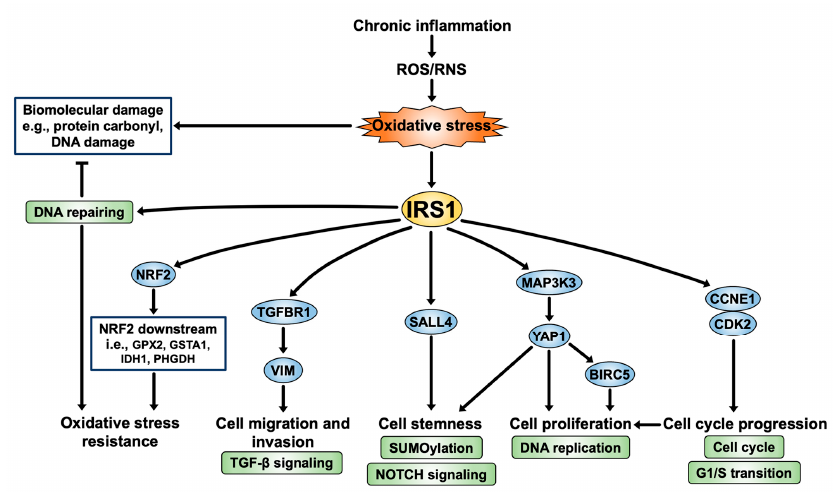
Figure 10. IRS1 signaling pathway: a perspective on CCA progression.